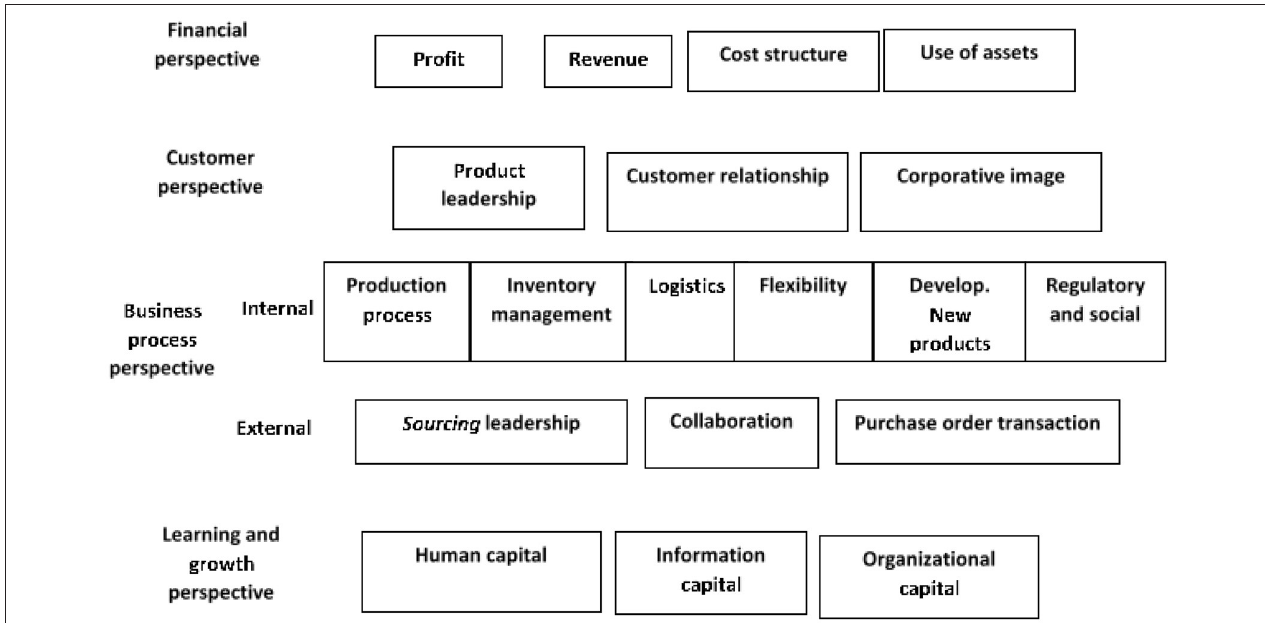
FIGURE 2 | Objectives in BSCS. Source: Park et al. (2005).